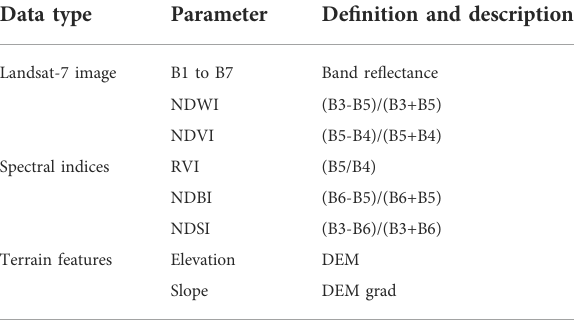
TABLE 2 Data and parameters.